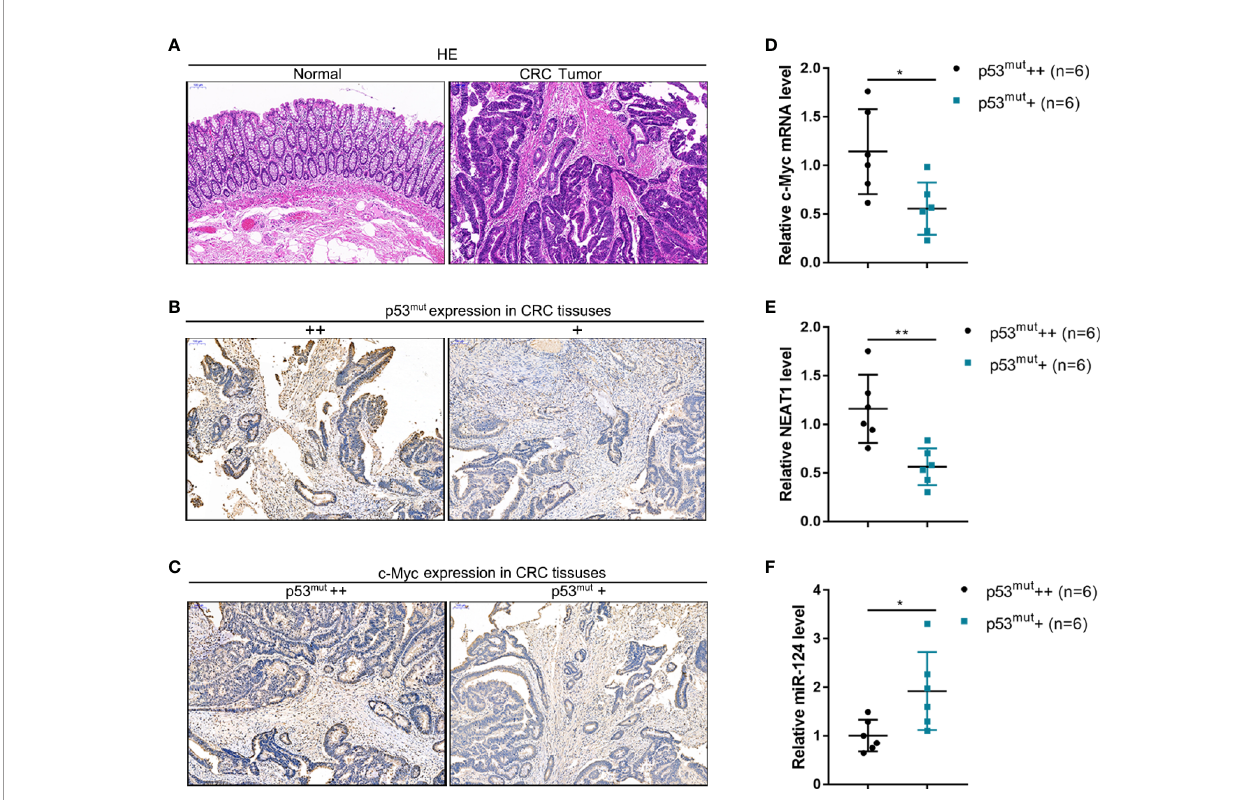
FIGURE 9 | The expression of the c-Myc/NEAT1/miR-124 in p53-mutant tissues (A) CRC and adjacent non-cancerous tissue samples were collated, and the histopathological characteristics were examined by H&E staining. (B) By using an antibody speci fi c to human p53 mutation, the p53 mutant in CRC tissue samples was identi fi ed by IHC staining. p53 mutant abundance was evaluated, and CRC tissues were divided into p53 mut + and p53 mut ++ groups accordingly. (C) C-Myc protein content was determined in p53 mut + and p53 mut ++ CRC tissues by IHC staining. (D – F) The expression levels of c-Myc, NEAT1, and miR-124 were determined in p53 mut + and p53 mut ++ CRC tissues by qRT-PCR. * P < 0.05, ** P < 0.01 compared with p53 mut +